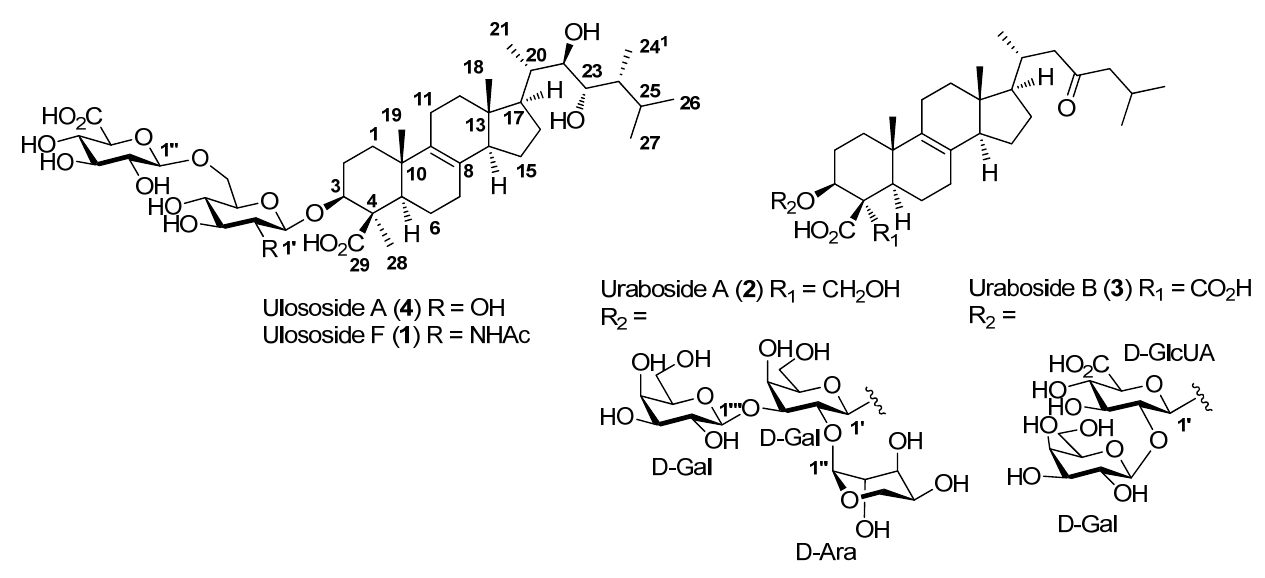
Figure 1. Structures of saponins 1 – 4 from E. ferox